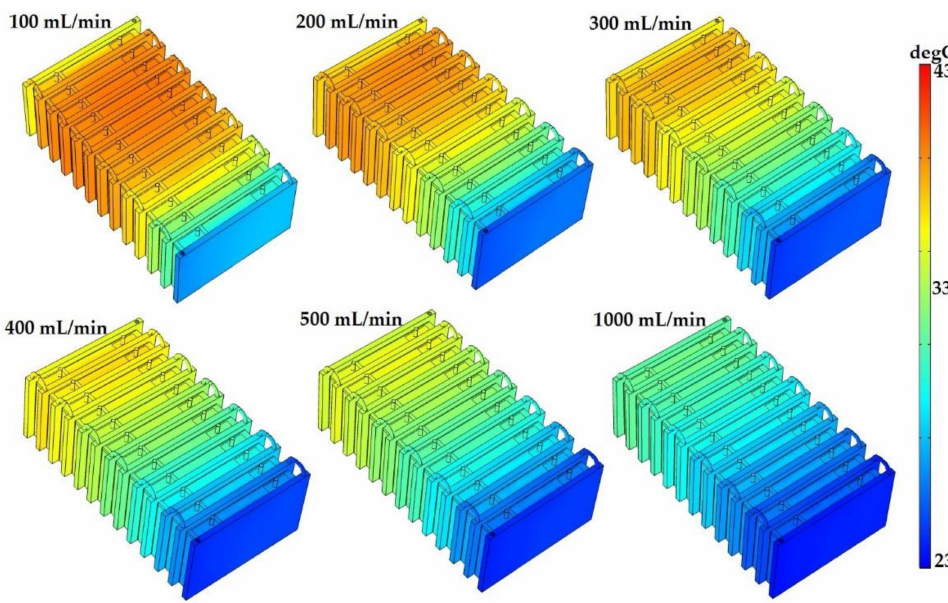
Figure 14. The temperature distribution of the module with different inlet flow rates.